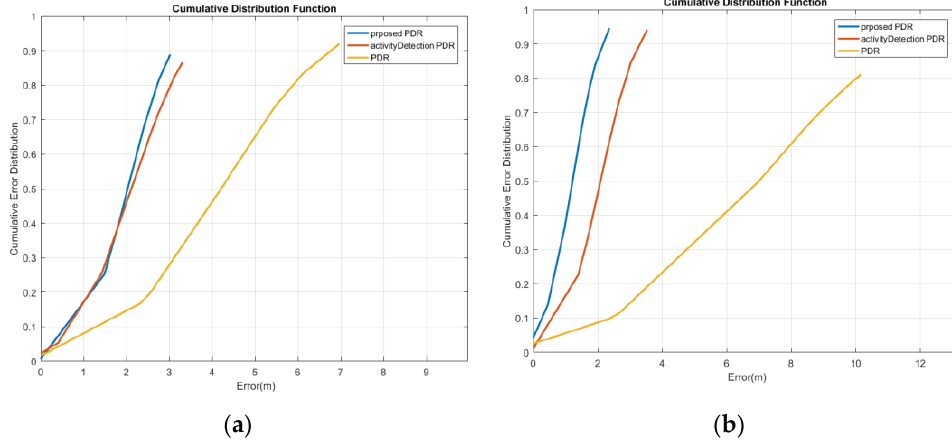
Figure 23. Cumulative error distribution of the swinging mode; ( a ) woman; ( b ) man.